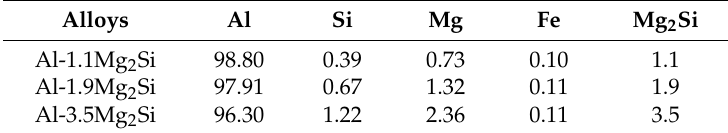
Table 1. The chemical compositions of studied